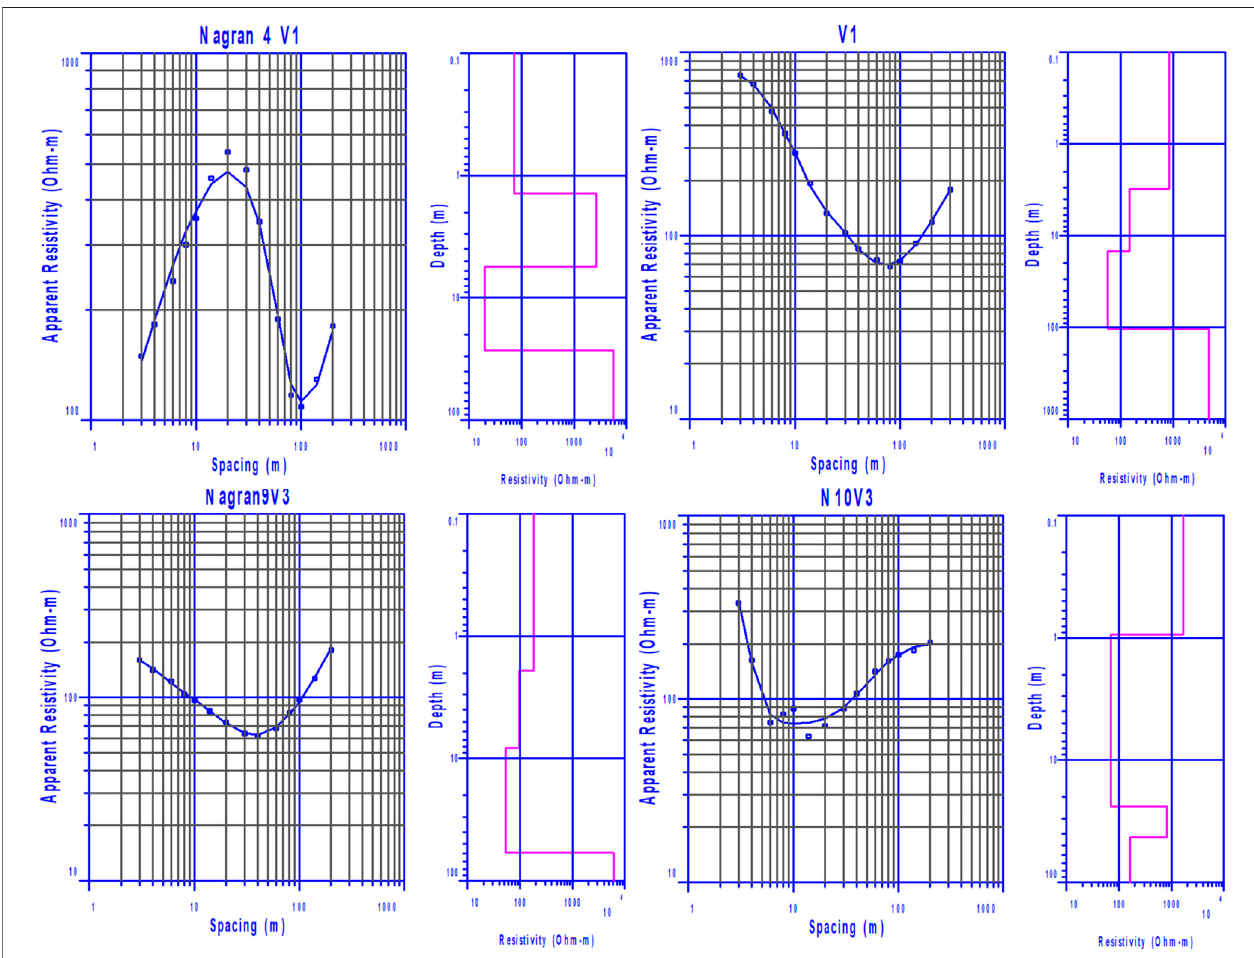
FIGURE 12 | The VES inverted